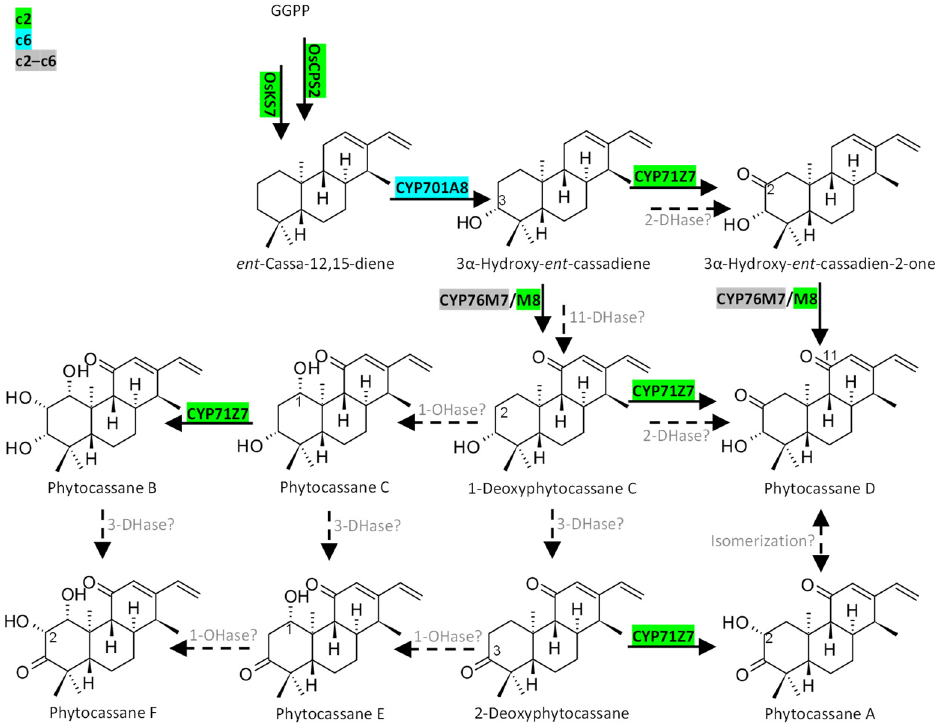
Figure 9. Proposed pathway for the biosynthesis of phytocassanes. The green highlight indicates enzymes encoded by genes belong to the biosynthetic gene cluster on chromosome 2 (c2BGC). Enzymes encoded by genes located on chromosomes 6 and in both 2 and 6 (c6 and c2–c6) are highlighted in blue and grey, respectively. GGPP: geranyl geranyl diphosphate; OsKS7 (OsKSL7; OsDTC1): ent -cassa-12,15-diene synthase (EC 4.2.3.28); OsCPS2 (OsCyc2): ent -copalyl diphosphate synthase (EC 5.5.1.13); CYP76M7: ent -cassadiene C11-alpha-hydroxylase 1 (EC 1.14.14.112); CYP76M8: oryzalexin D synthase (EC 1.14.14.112; 1.14.14.123); CYP701A8: ent -sandaracopimaradiene 3-hydroxylase (EC 1.14.14.70); C71Z7: ent -cassadiene hydroxylase (EC 1.14.14.69) (adapted from [138]).